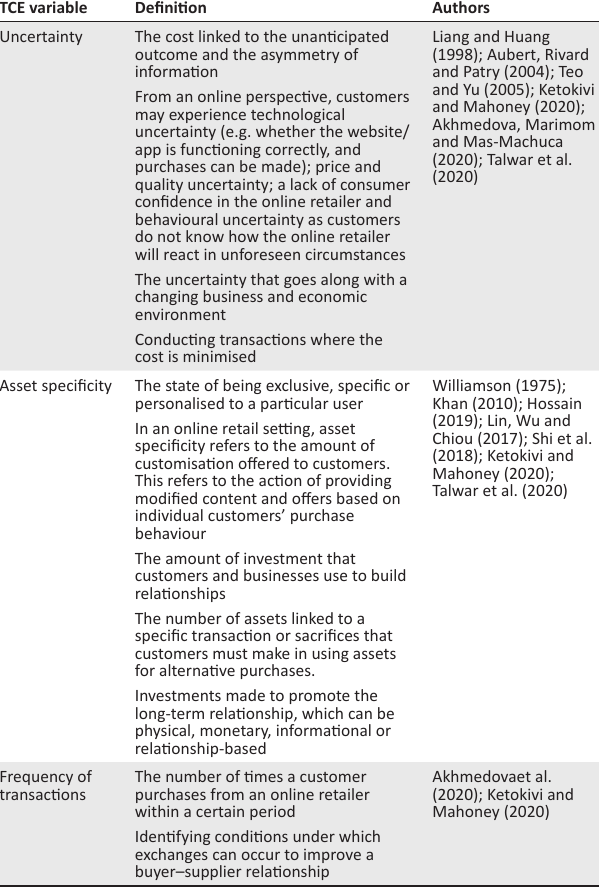
TABLE 1: Transaction cost economics dimensions and their